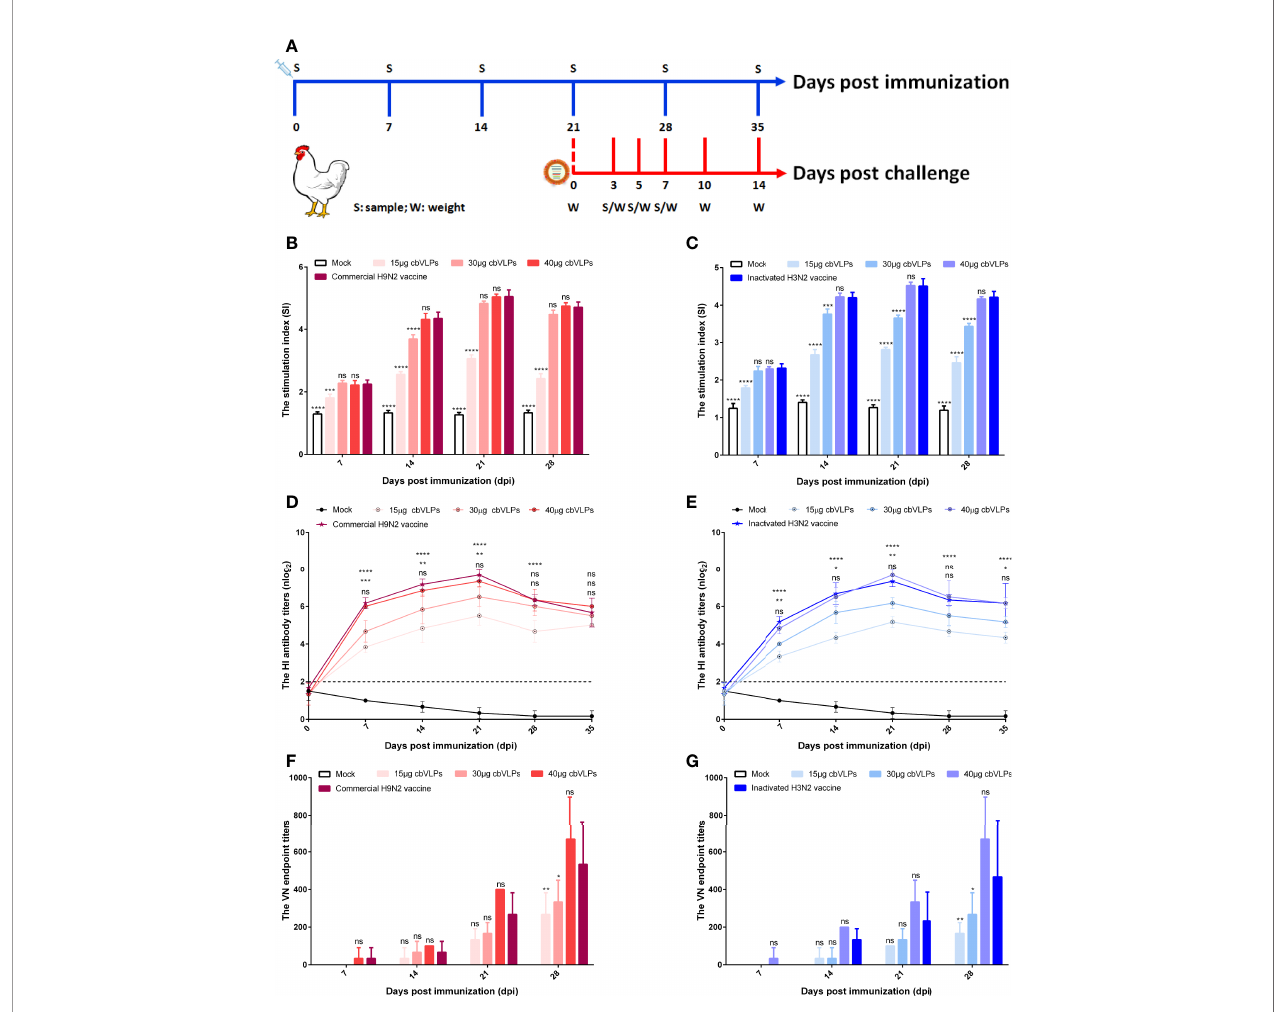
FIGURE 5 | The immune response of chickens after immunization with cbVLPs. Panel (A) : Animal experimental design for immunization and challenge. Panels (B, C) : The splenic lymphocyte proliferation after stimulation with H9N2 or H3N2 AIV strains, respectively. The results were presented in the form of the stimulation index (SI), which reached a peak on 21dpi. Panels (D, E) : The dynamic change of HI antibody titers in the sera against homologous H9N2 or H3N2 AIV strains, respectively. A sustained increase in the HI antibody titers was observed in all cbVLP groups up to 3 weeks after immunization. Panels (F, G) : The VN antibody titers against homologous H9N2 or H3N2 AIV strains, respectively. As can be seen the trend is similar to what is observed in Panels (D) or (E) , but with higher levels of antibodies against corresponding antigen. Signi fi cance of difference was compared between cbVLPs and commercial H9N2 vaccine or inactivated H3N2 vaccine by a Two-Way ANOVA test. Statistical differences were indicated by asterisk (ns P > 0.05, *P < 0.05, **P < 0.01, ***P < 0.001, ****P <